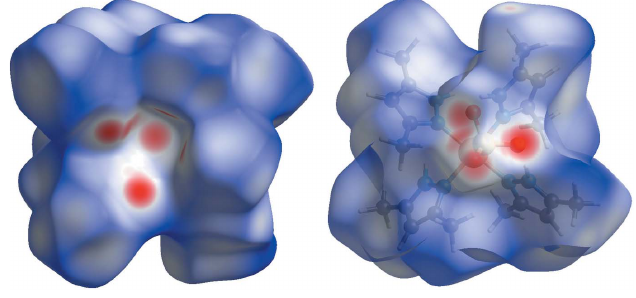
Figure 6 Two projections of Hirshfeld surfaces mapped over d norm showing the intermolecular interactions.